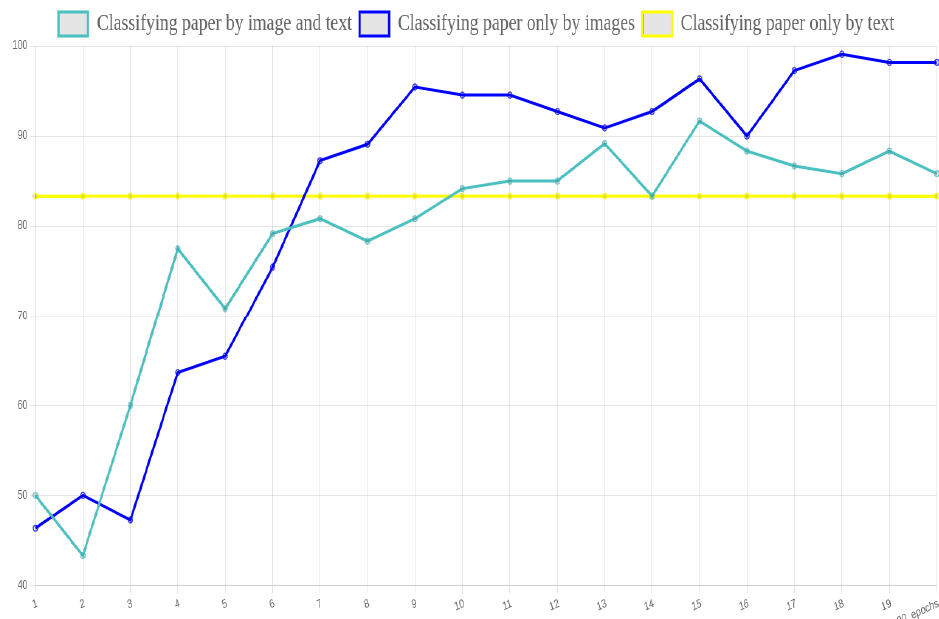
Figure 2. Trend of accuracy in different epochs.